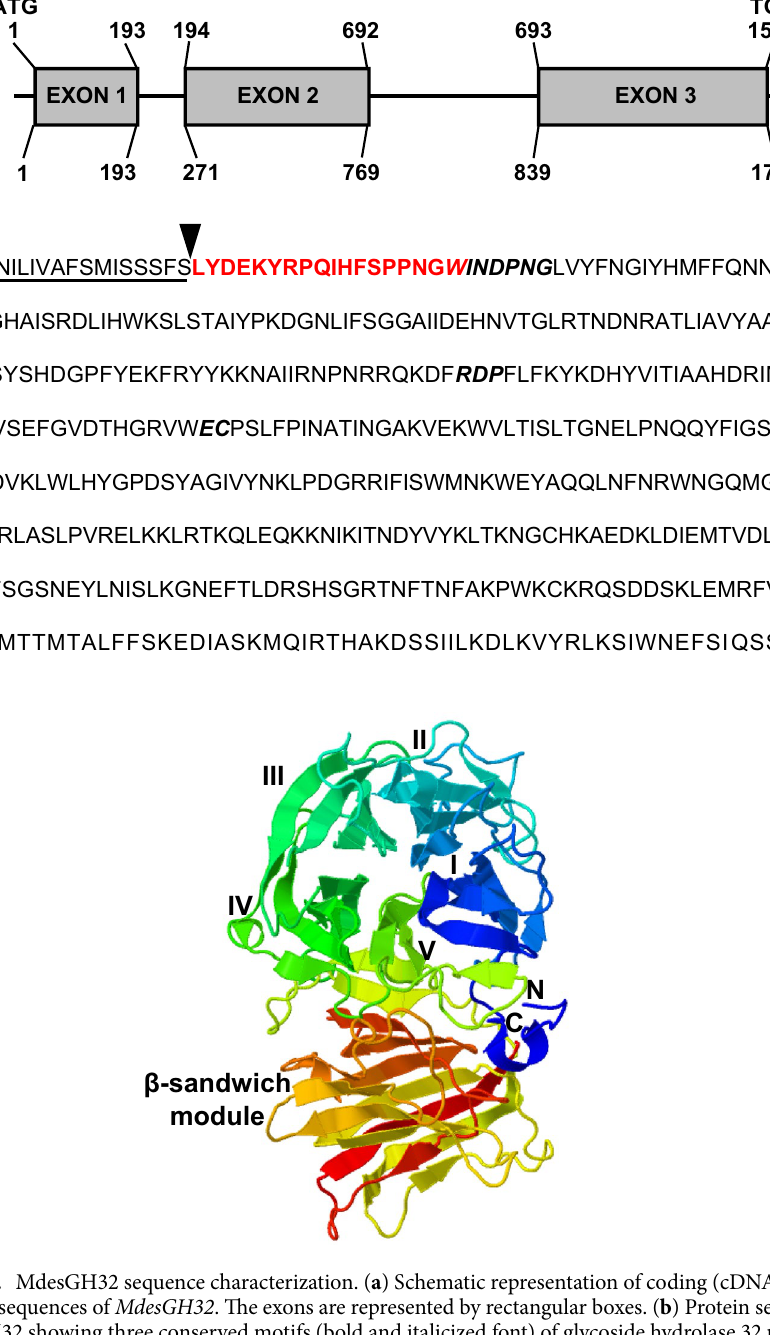
the larvae were removed from the crown tissue during collections from these susceptible wheat lines. Gel blot analysis revealed the presence of MdesGH32 in the total plant proteins prepared from both susceptible wheat lines (Fig. 2d and Supplementary Fig. 2). The band intensity in the susceptible wheat lines was faint at 3 and 5 DAH but increased strongly by 8 DAH (Fig. 2d). Gel blot analysis of the purified recombinant MdesGH32 with the pre-immune serum did not yield any positive signal (Supplementary Fig. 3a).